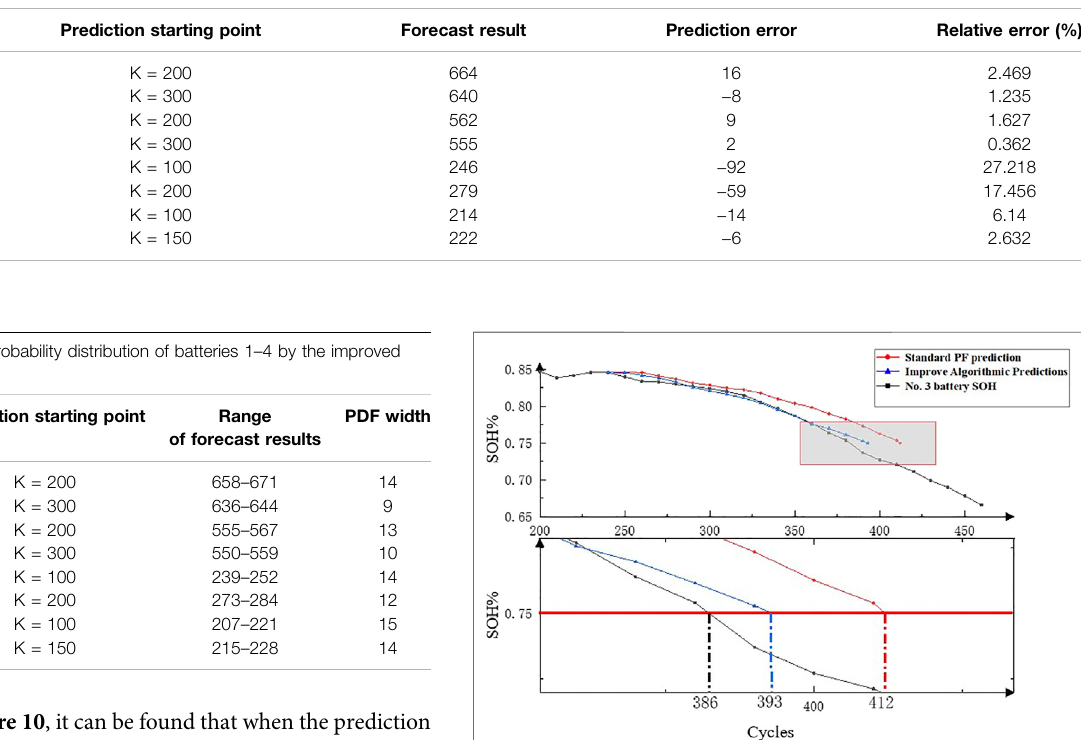
TABLE 4 | Prediction results of the improved particle fi lter algorithm for batteries 1 – 4.